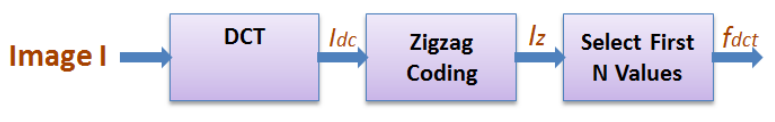
Figure 3. DCT based Feature